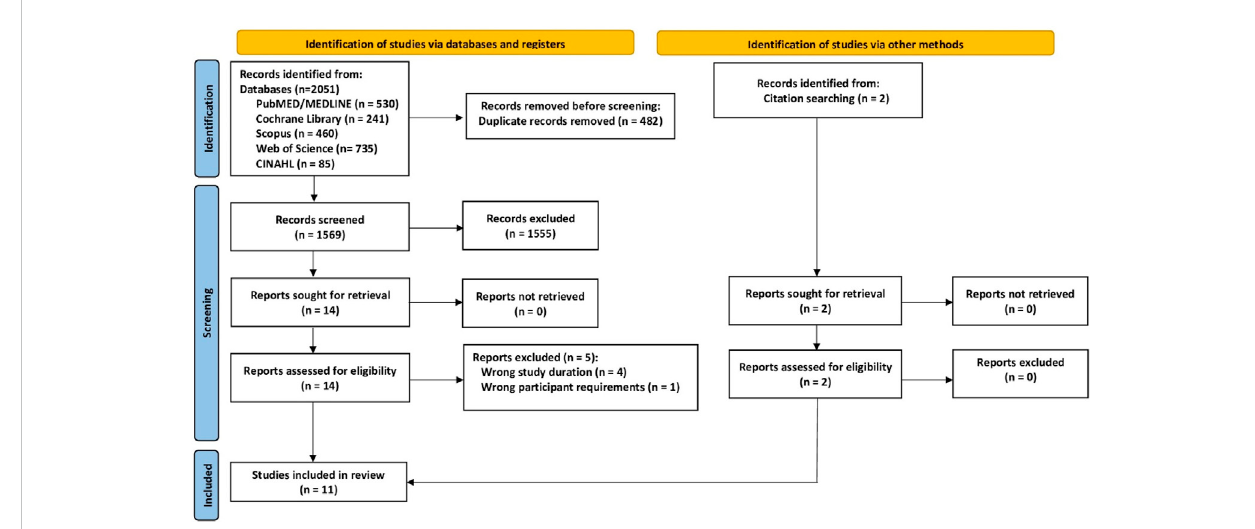
FIGURE 1 Flow chart of the present study according to PRISMA. Adapted from (Page et al.,